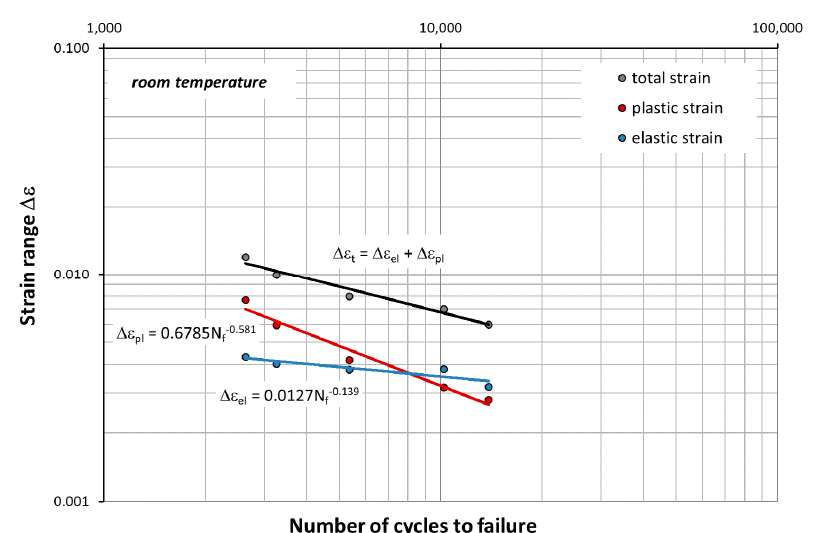
Figure 16. Range strain Δ ε versus the number of cycles to failure N f at room temperature described by Formula (1).